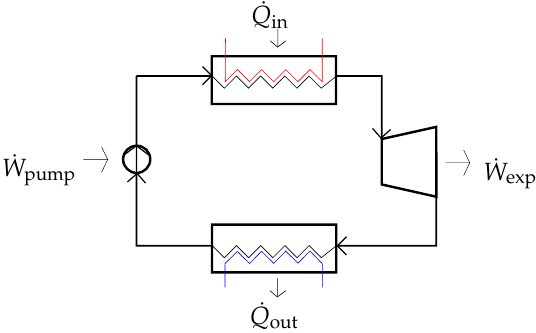
Figure 4. Schematic of the sub-critical organic Rankine cycle (ORC)